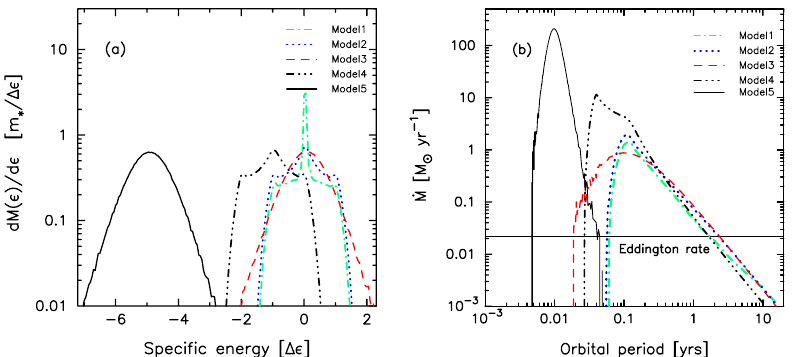
Figure 1. Di ff erential mass distributions over specific energy of stellar debris and their corresponding mass-fall back rates. While the di ff erential mass distribution is shown in panel (a), the mass fallback rate is shown in panel (b). In both panels, the dot-dashed line (green), dotted line (blue), dashed line (red), dashed-three-dotted line (black), and solid line (black) represent the mass distributions and corresponding mass fallback rates of Model 1, Model 2, Model 3, Model 4 and Model 5, respectively. The energy is measured in units of ∆(cid:8) given by equation